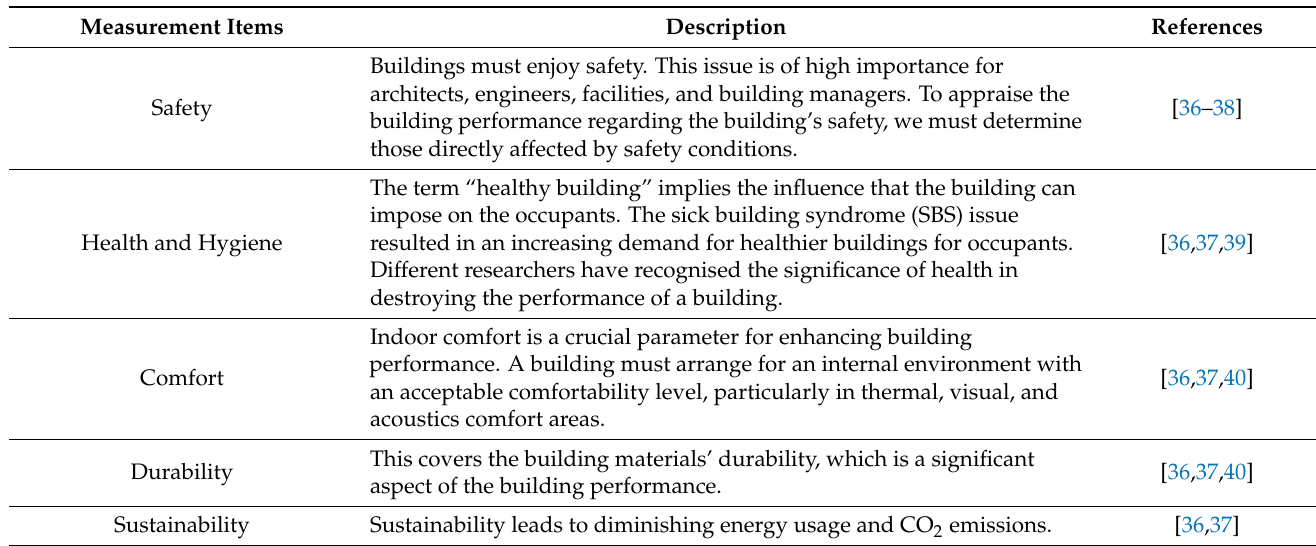
Table 2. Building performance